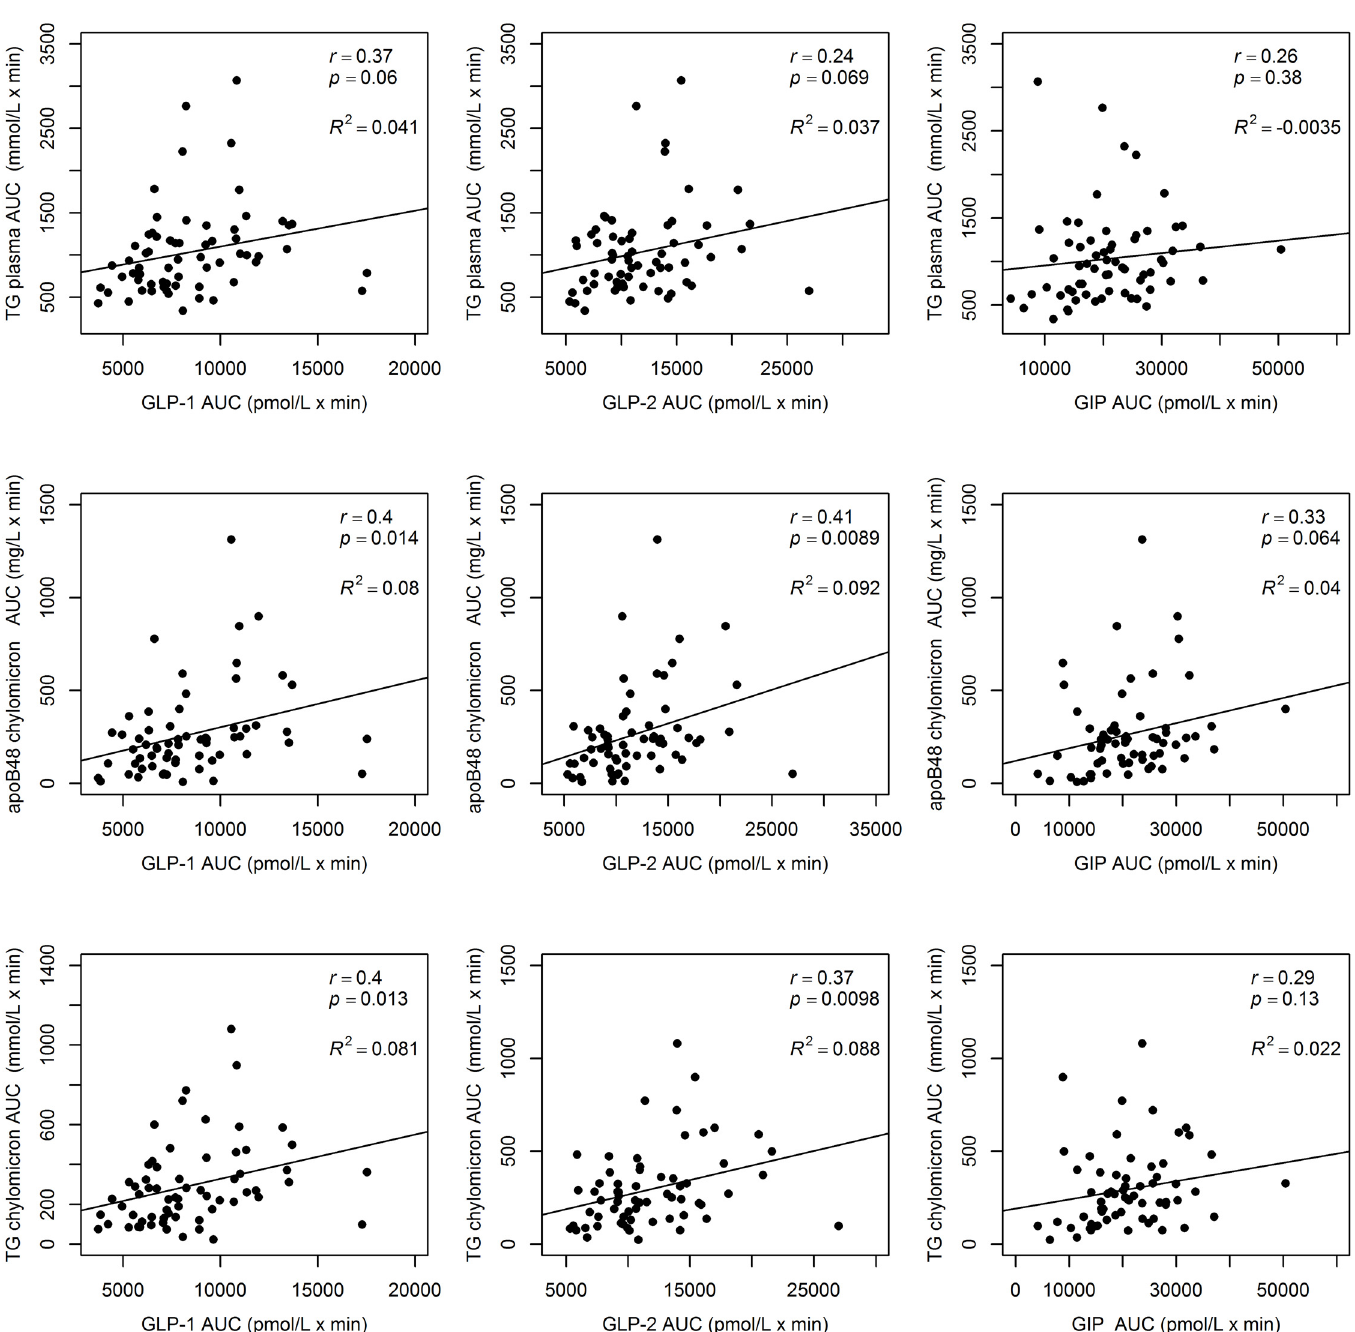
Fig 2. Correlation between incretins and postprandial lipid responses. Correlations between areas under curve (AUC) for GLP-1, GLP-2 and GIP with plasma TG, apoB48 in the chylomicron fraction, and triglycerides in the chylomicron fraction after the fat-rich